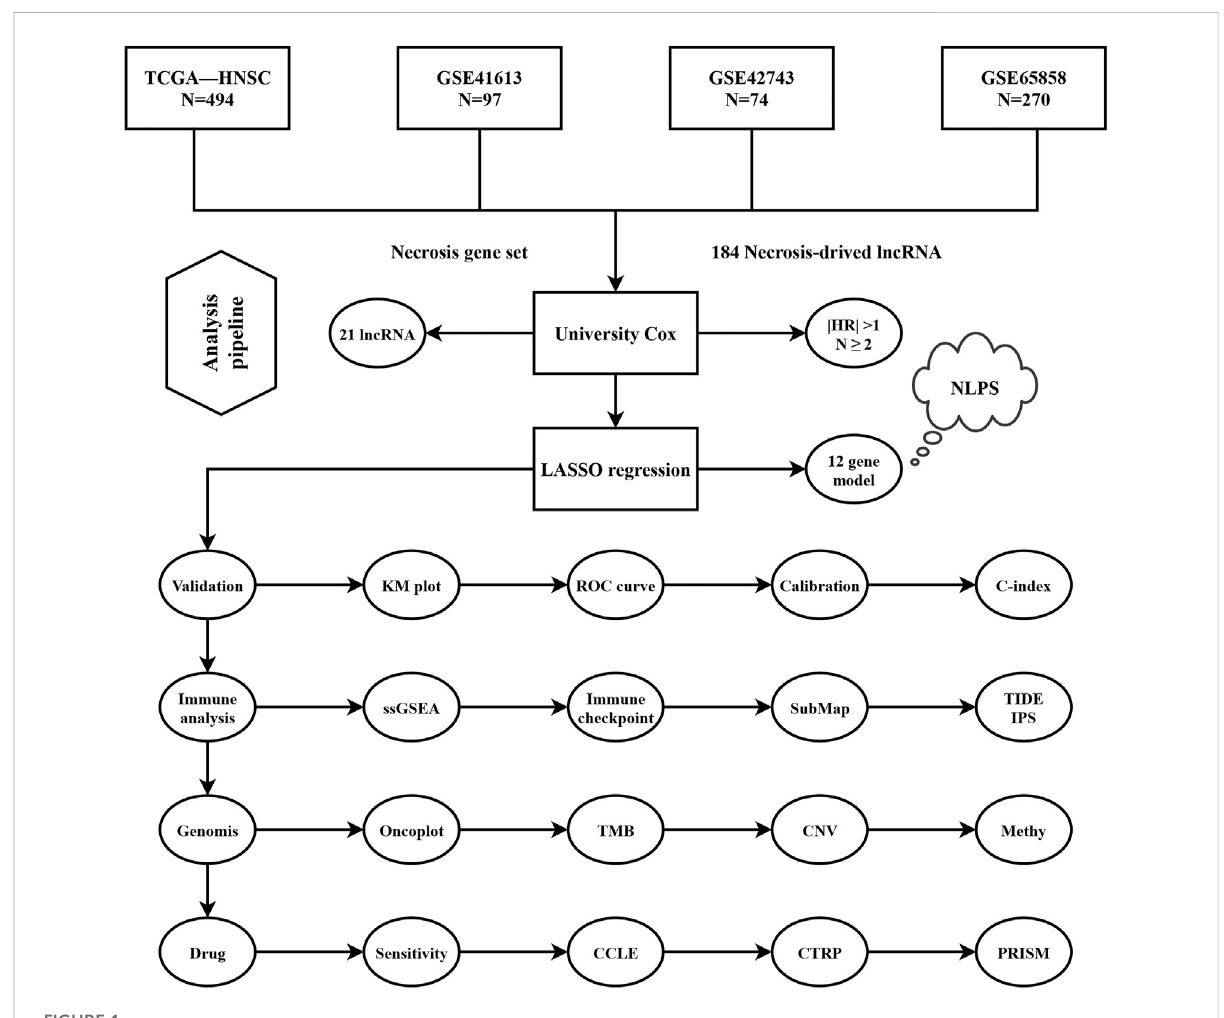
FIGURE 1 Flowchart of analysis